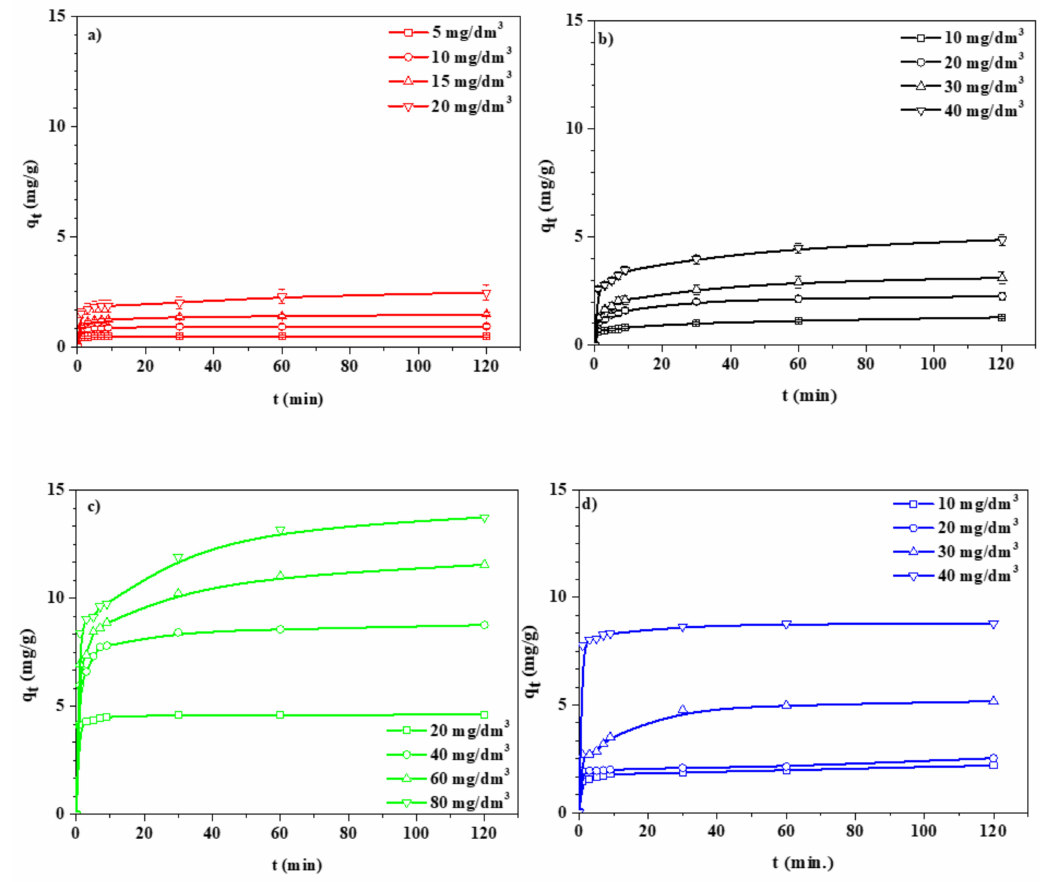
Figure 7. Influence of initial concentration on adsorption onto NaP1CS ( a ) Cu(II)–IDHA, ( b ) Fe(III)–IDHA, ( c ) Mn(II)–IDHA, ( d ) Zn(II)–IDHA (m = 0.1 g, t = 120 min., A = 7, 180 rpm, pH =